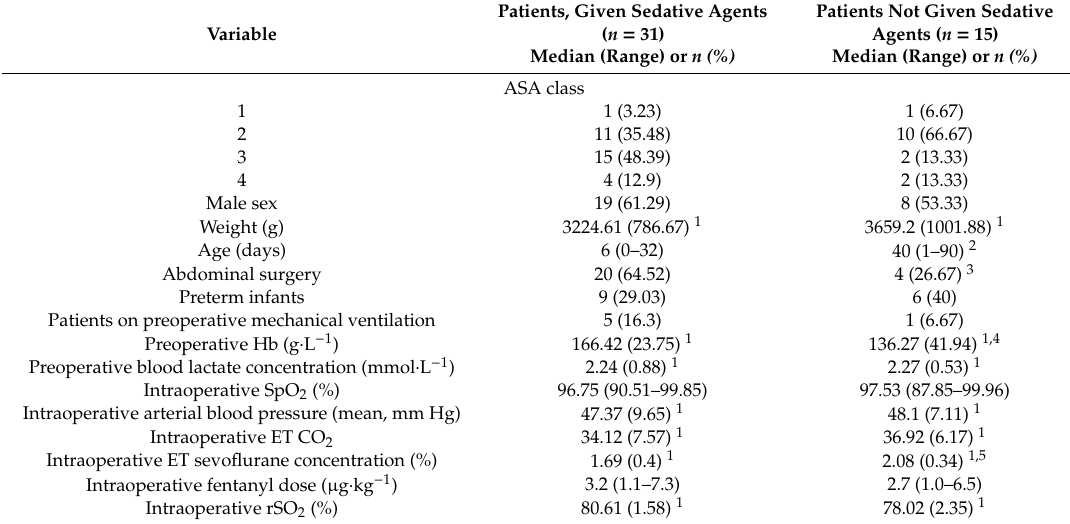
Table 4. Comparison of the clinical variables between patients given and not given sedative agents